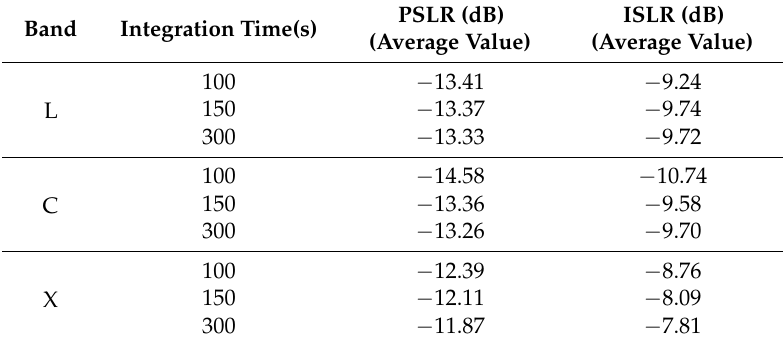
Table 4. The imaging results in extreme unstable atmospheric conditions for different bands and integration time. Band Integration Time(s)